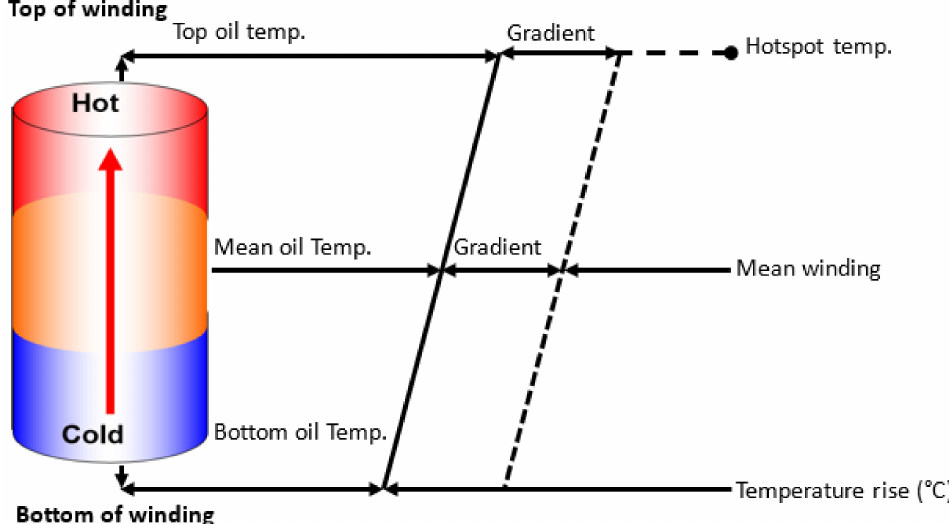
Figure 1. Basic transformer thermal